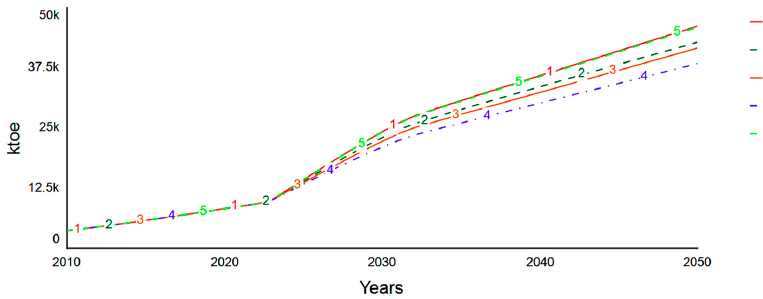
Figure 10. Total renewables subjected to different (cross) price elasticities.